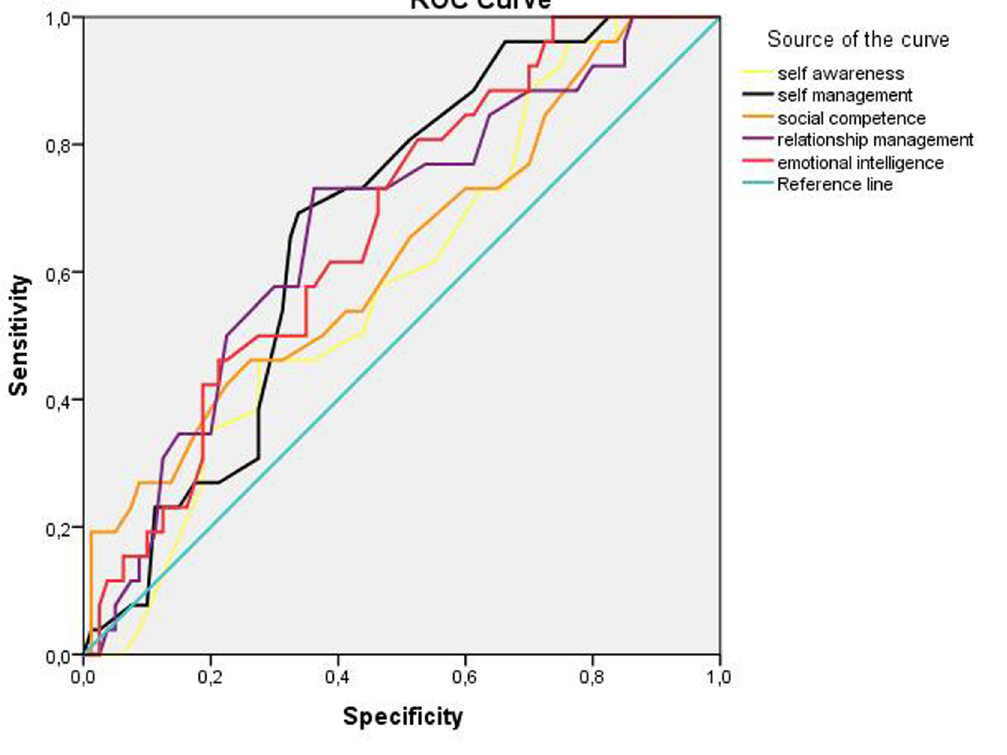
Figure 1. The Roc